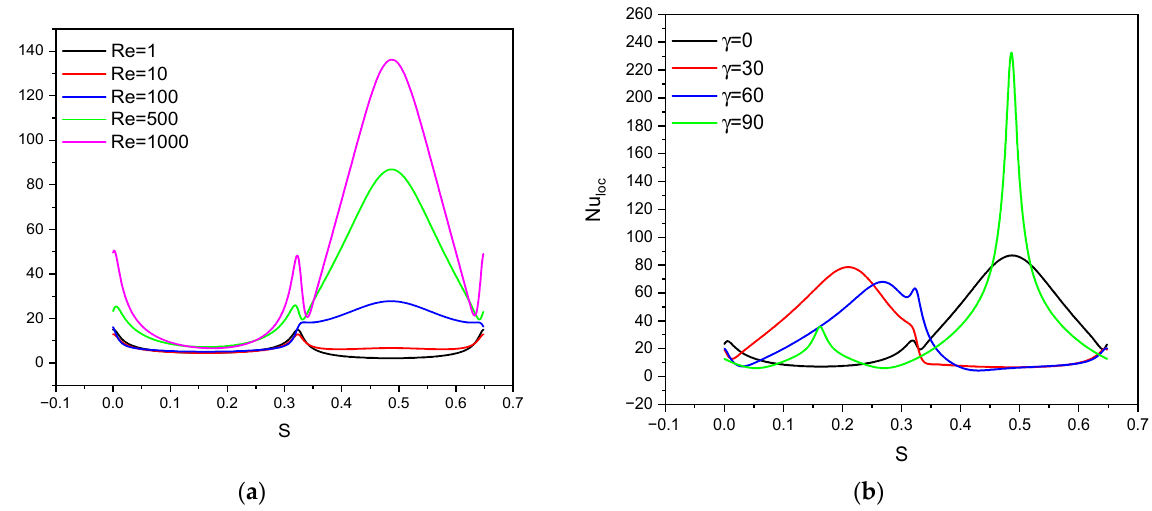
Figure 10. Features of the local Nusselt number Nu loc for ( a ) variations of the Reynolds number Re and ( b ) variations of the elliptic-shaped inclination angle γ at Ha = 0, Ste = 0.2.